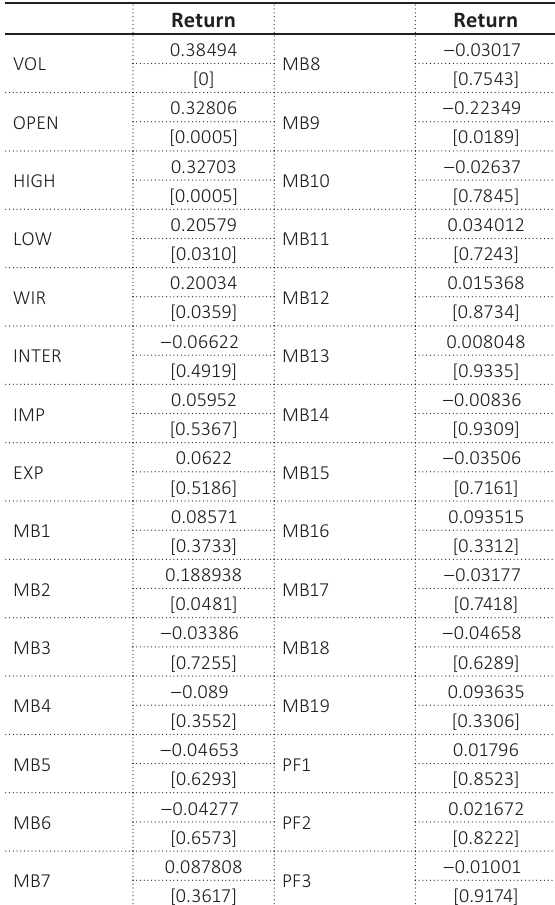
Table 3. Pairwise